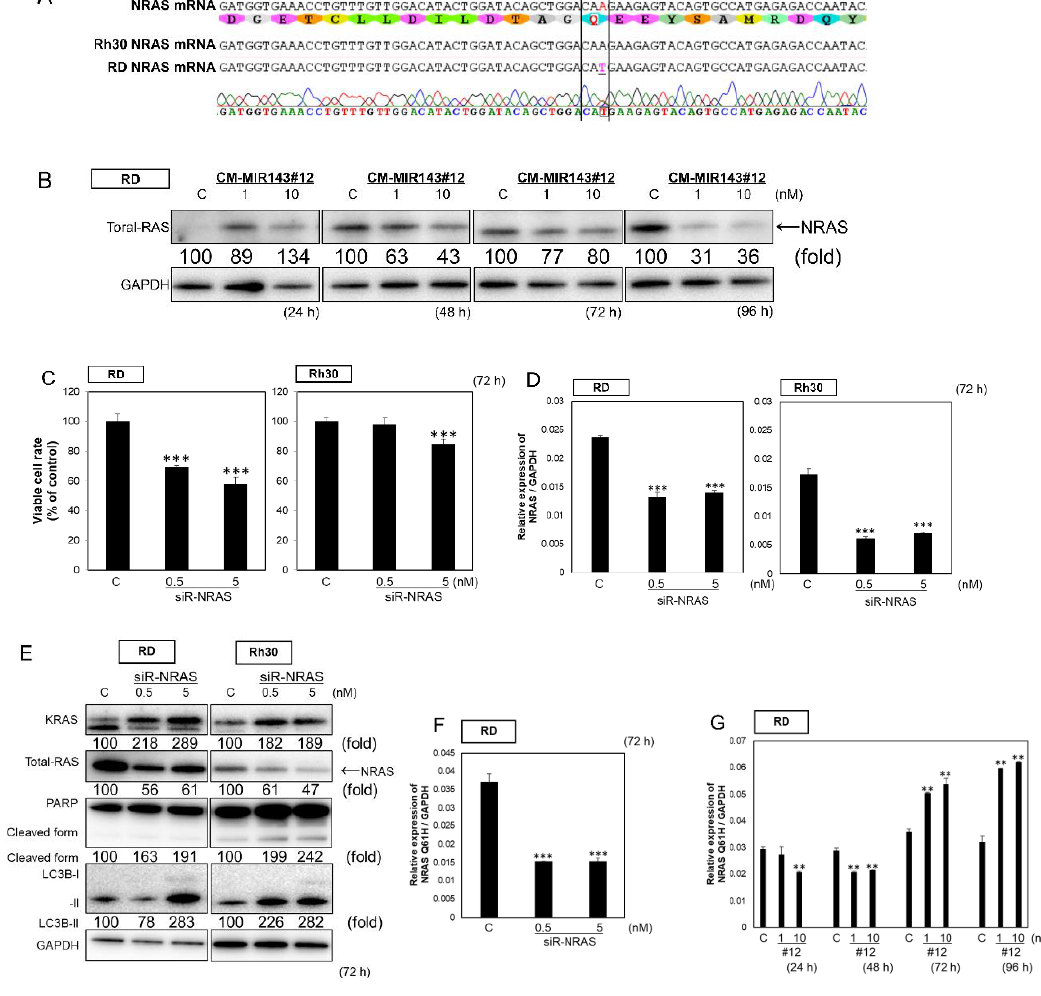
Figure 3. ( A ) Sequence verification of NRAS in RD and Rh30 cells. ( B ) Time course of protein expression of NRAS in RD cells at 24, 48, 72, and 96 h after transfection with CM-MIR143#12 (1, 10 nM). ( C , D , E ) Effects of ectopic expression of siR-NRAS on the cell viability of RMS cells ( C ), the mRNA expression of total NRAS estimated by qPCR analysis ( D ), and the protein expression of KRAS, NRAS, PARP, and LC3B estimated by Western blot analysis 72 h after treatment of RD ( E ) and RD cells with siR-NRAS at a concentration of 0.5 or 5 nM ( F , G ), changes in NRAS -Q61H mRNA levels in siR-NRAS ( F ) or CM-MIR143#12 ( G )-transfected RD cells. Results are presented as the mean ± SD; ** p < 0.01; *** p < 0.001.